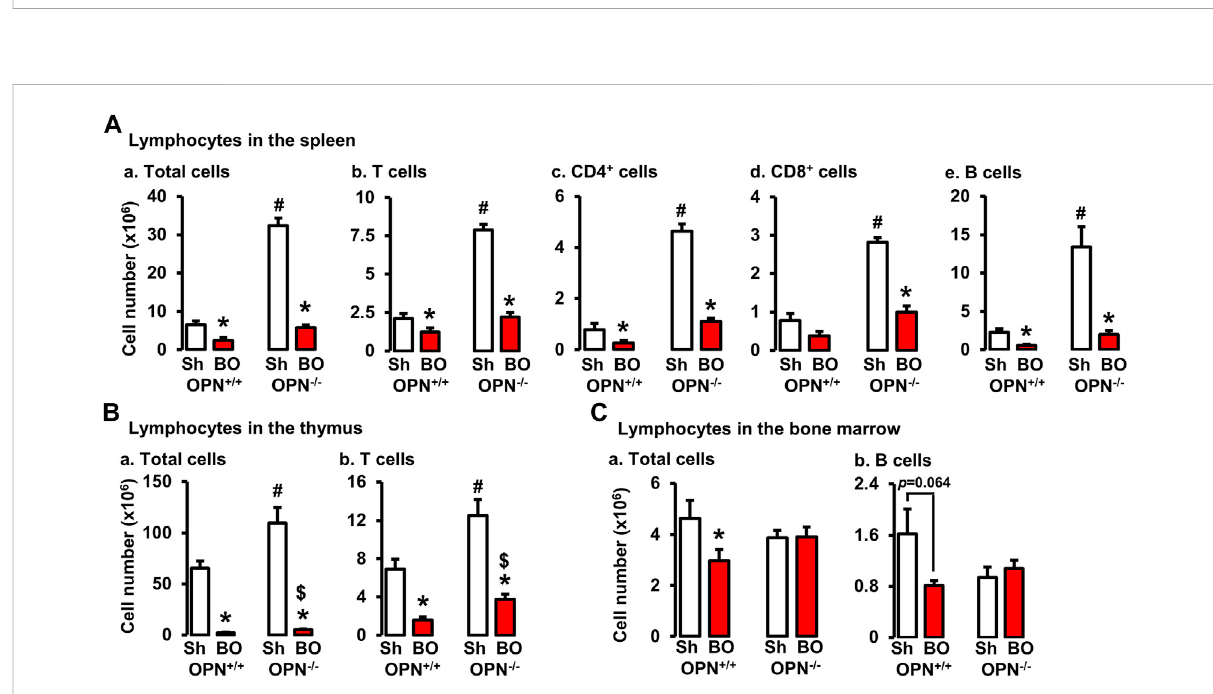
FIGURE 8 Effectsofbowelobstructiononspeci fi clymphocytesinlymphoidorgansinwild-type(OPN+/+)andosteopontinknockout(OPN − / − )mice. (A) Numbers of total live lymphocytes (A) , T cells (B) , CD4 + cells (C) , CD8 + cells (D) and B cells (E) in the spleen of OPN +/+ and OPN − / − mice with sham operation (Sh) and obstruction (BO, 4 days). (B) Numbers of total live lymphocytes (A) and T cells (B) in the thymus of OPN +/+ and OPN − / − mice with sham operation (Sh) and obstruction (BO, 4 days). (C) Numbers of total live lymphocytes (A) and B cells (B) in the bone marrow of OPN +/+ and OPN − / − mice with sham operation (Sh) and obstruction (BO, 4 days). N = 6 or 7. * p ≤ 0.05 vs. sham of the group. # p ≤ 0.05 vs. sham of OPN +/+ . $ p ≤ 0.05 vs. BO of OPN +/+